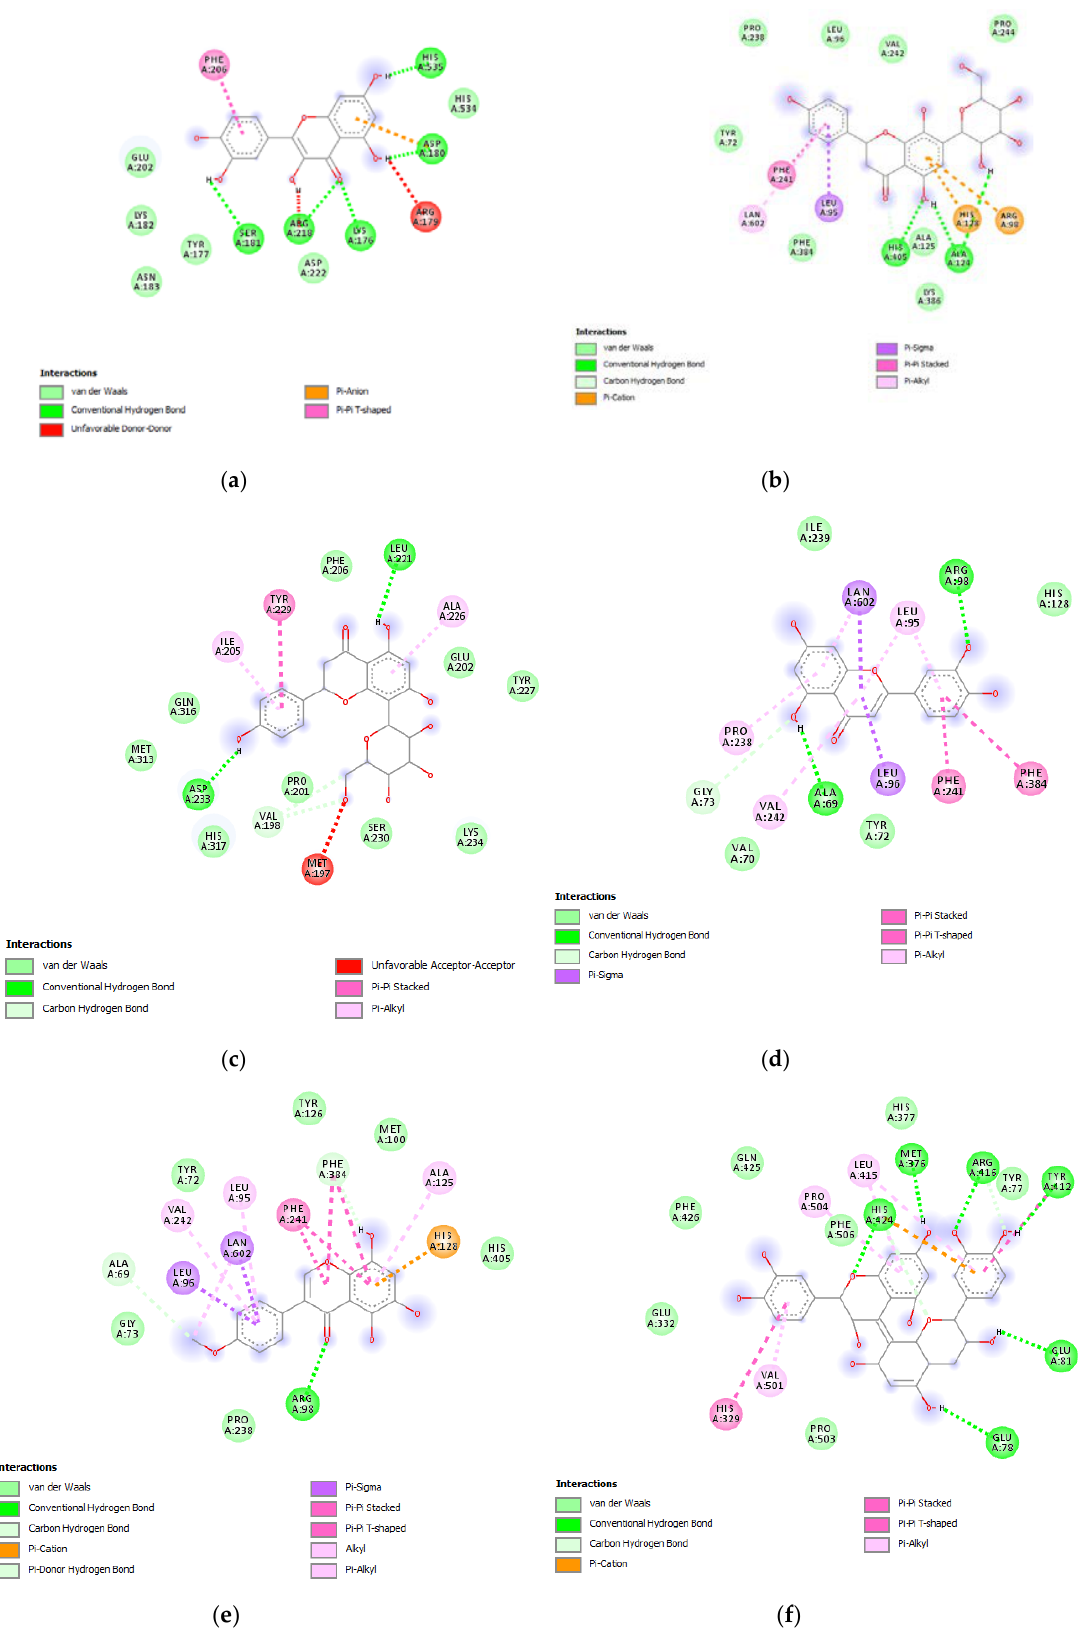
Figure 9. ( a ) Putative interactions between quercetin and lanosterol-14-alpha demethylase (PDB: 4LXJ). Free energy of bind ing (ΔG) and affinity (Ki) are − 8.8 kcal/mol and 0.4 μM, respectively. ( b ) Putative interactions between isovitexin and lanosterol-14-alpha demethylase (PDB: 4LXJ). Free energy of binding (ΔG) and affinity (Ki) are −9 .4 kcal/mol and 0.1 μM, respectively. ( c ) Putative interactions between vitexin and lanosterol-14-alpha demethylase (PDB: 4LXJ). Free energy of binding (ΔG) and affinity (Ki) are −9 .4 kcal/mol and 0.1 μM, respectively. ( d ) Putative interactions